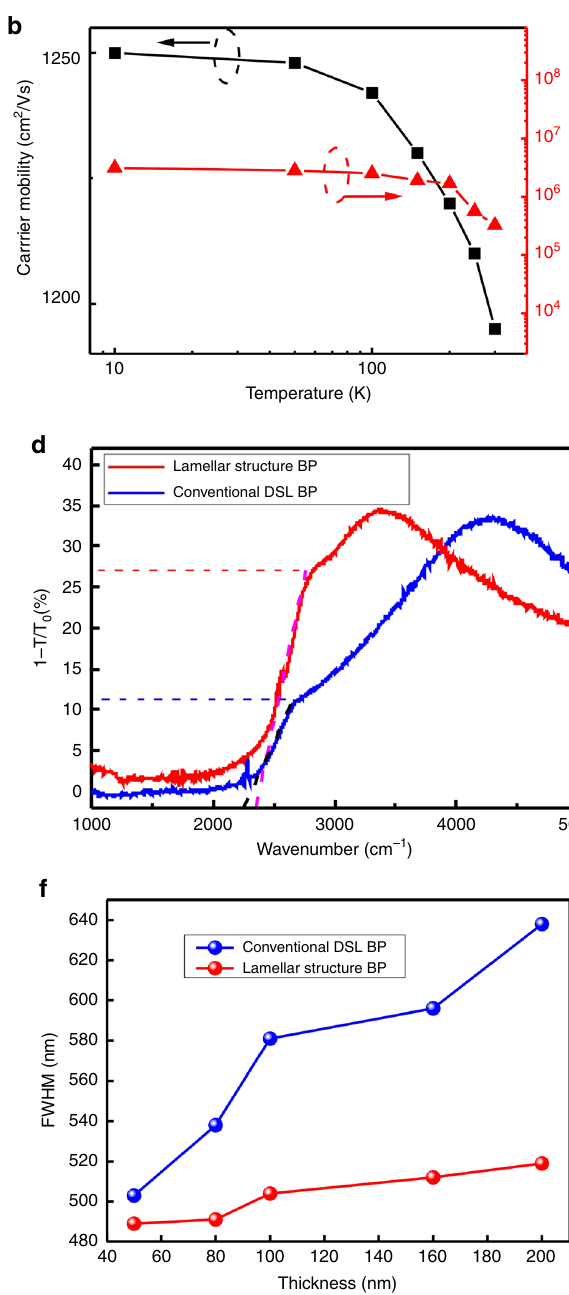
Fig. 4 Electrical and infrared optical properties of the as-grown BP fi lms. a Output and transfer curves of the FETs utilizing the synthesized BP fi lm as channel materials. Transfer characteristics was measured under gate voltage V g swept from − 30 to 50 V with fi xed source-drain voltage V ds = 100 mV. The output result is demonstrated in the insert, measured under V ds swept from − 50 to 50 mV, and different gate voltages from − 40 to 20 V with 20 V as step. Electrical characterizations demonstrate a typical p-type ambipolar transport behavior of the BP sample. b Carrier mobility and current on/off ratio as a function of temperature in a synthesized BP fi lm. Field-effect mobility of over 1200 cm 2 V − 1 s − 1 and excellent current on/off ratio as high as 10 6 for gate voltages in the range of − 40 to 40 V can be achieved. c Hall mobility (red line) and carrier concentration (blue line) of the BP fi lm as a function of temperature. Insert is the AFM topography image of a Hall-bar device employed for the characterization, where the line pro fi le indicates the thickness of the BP is ~ 8 nm. d Infrared absorption spectra of the as-grown lamellar structure BP fi lm (red line) and the BP derived from conventional bulk crystal (blue line). e PL spectra of the as-grown lamellar structure BP fi lm (red line) compared with BP derived from conventional bulk crystal (blue line). f The thickness dependence of the full width at half maximum of the PL spectra for the as-grown lamellar structure BP fi lm (red line) and those derived from conventional BP bulk crystal (blue line). All the spectra measurements were carried out at ambient conditions, and employing two types of BP with the same